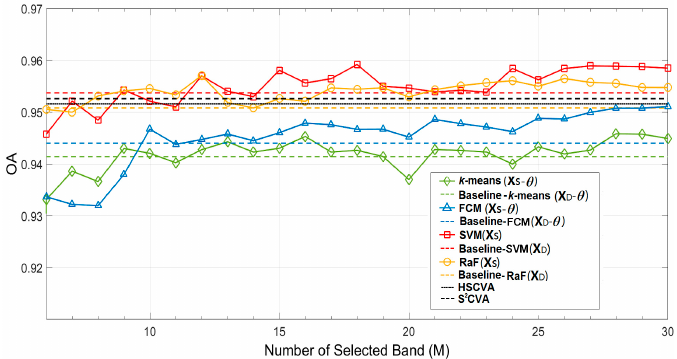
Figure 15. Multiple CD accuracies obtained by the proposed CD approaches based on BS-DR and by the reference methods (Umatilla County dataset). The unsupervised k -means and FCM were applied on the compressed direction of X S (i.e., X S - α ) and the supervised SVM-based and RaF-based were applied on the uncompressed X S . Baseline results on X D in the proposed approaches and in two reference methods are shown as dashed lines for comparison purposes.